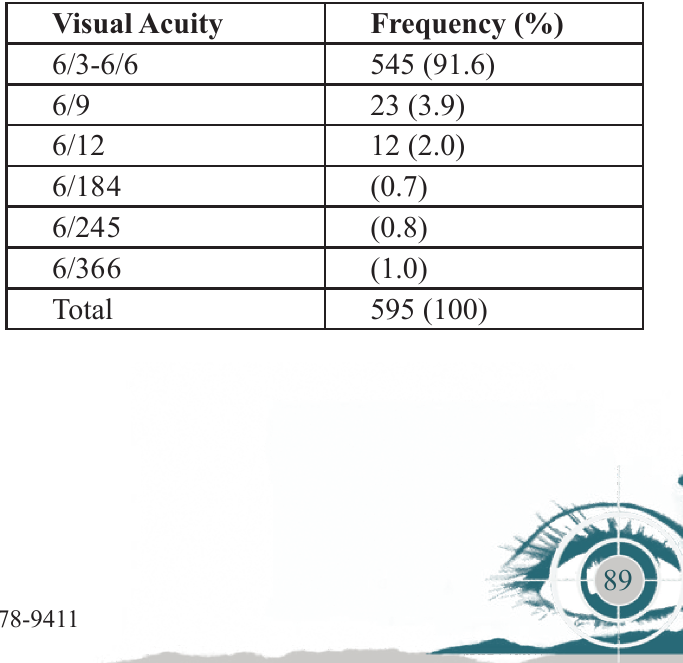
Table 1: Distribution of Presenting Visual Acuity in the Better Seeing